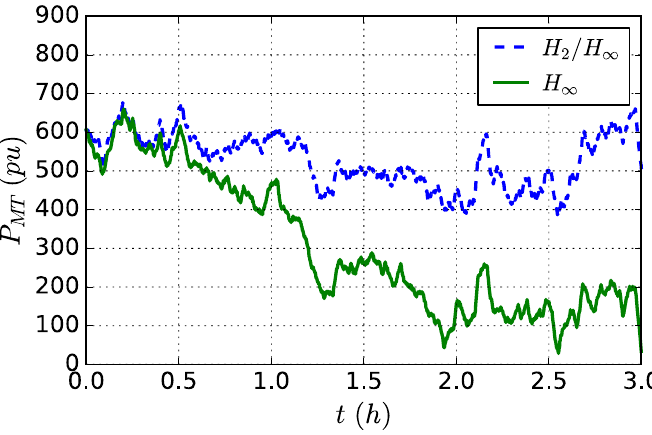
Figure 6. Power dynamics of micro-turbines (MT) under mixed H 2 / H ∞ control and H ∞ control schemes.